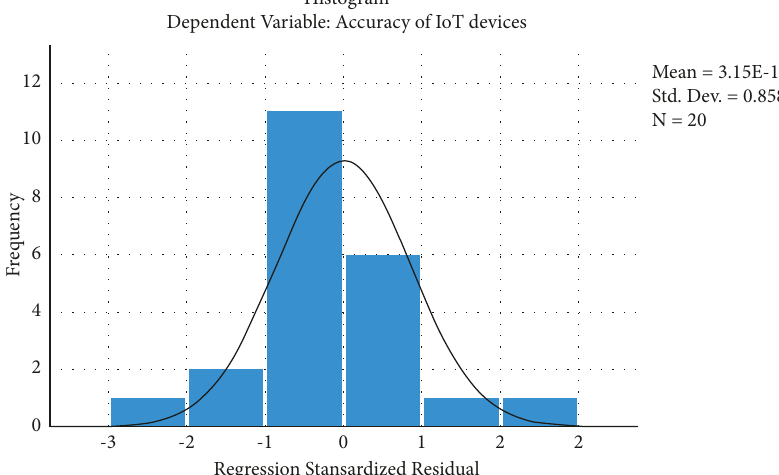
Figure 8: Histogram analysis of the accuracy of IoT devices. Research center R&D on application, platform, etc. Hospital Patient remote monitoring, data analysis, etc.